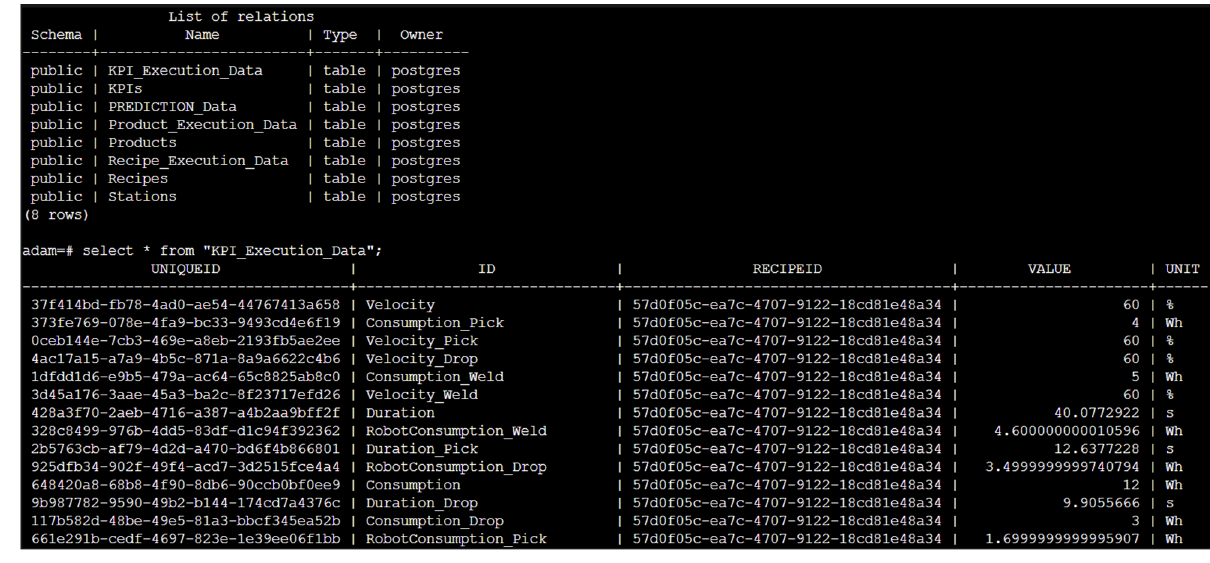
Figure 17. Database visualization.